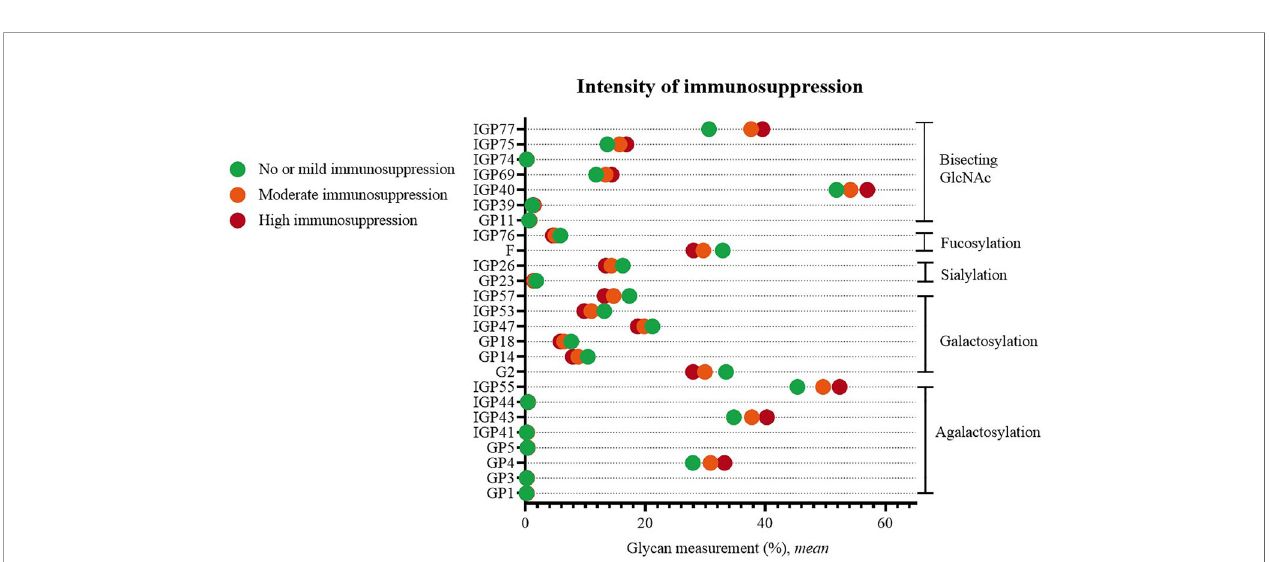
FIGURE 4 | Signi fi cant differences in glycan measurements in patients of different degrees of systemic immunosuppression.